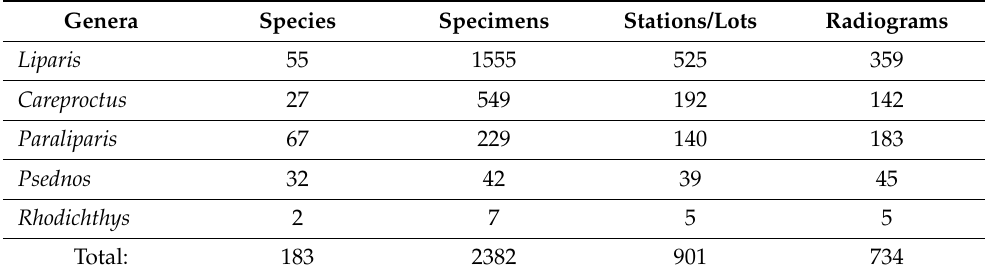
Table 1. Volume of processed material of fishes of the family Liparidae,